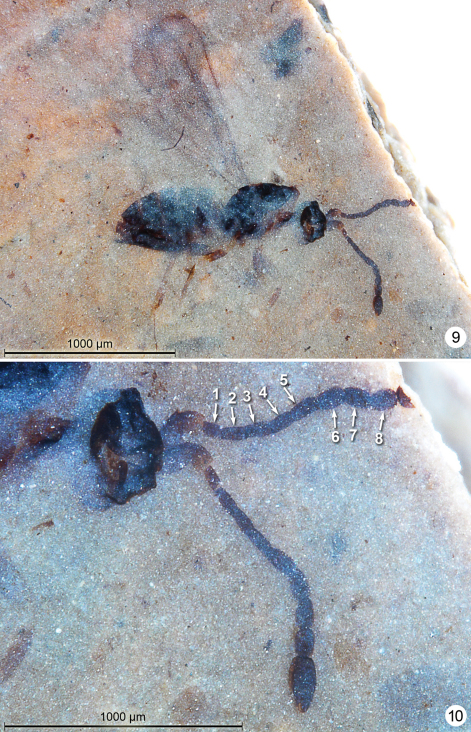
Gonatocerus kootenai, holotype 9 habitus lateral 10 head and antennae.